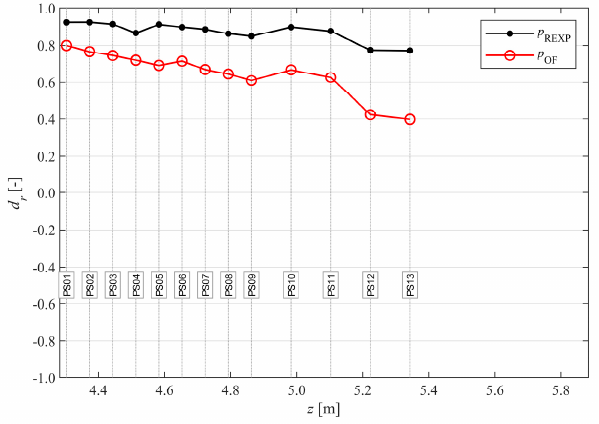
Figure 12. Index d r of REXP and OF with EXP, for p at the vertical wall (horizontal axis). Table 5. Pattern and model performance statistics for all p (PS) and F x (LC) measurement locations.